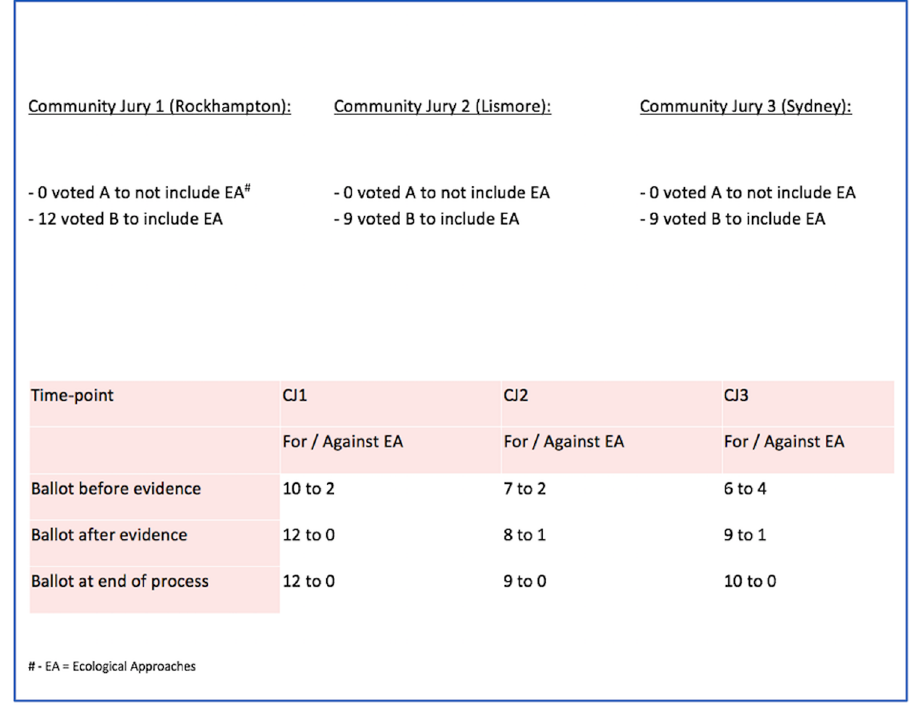
Fig 4. Final jury